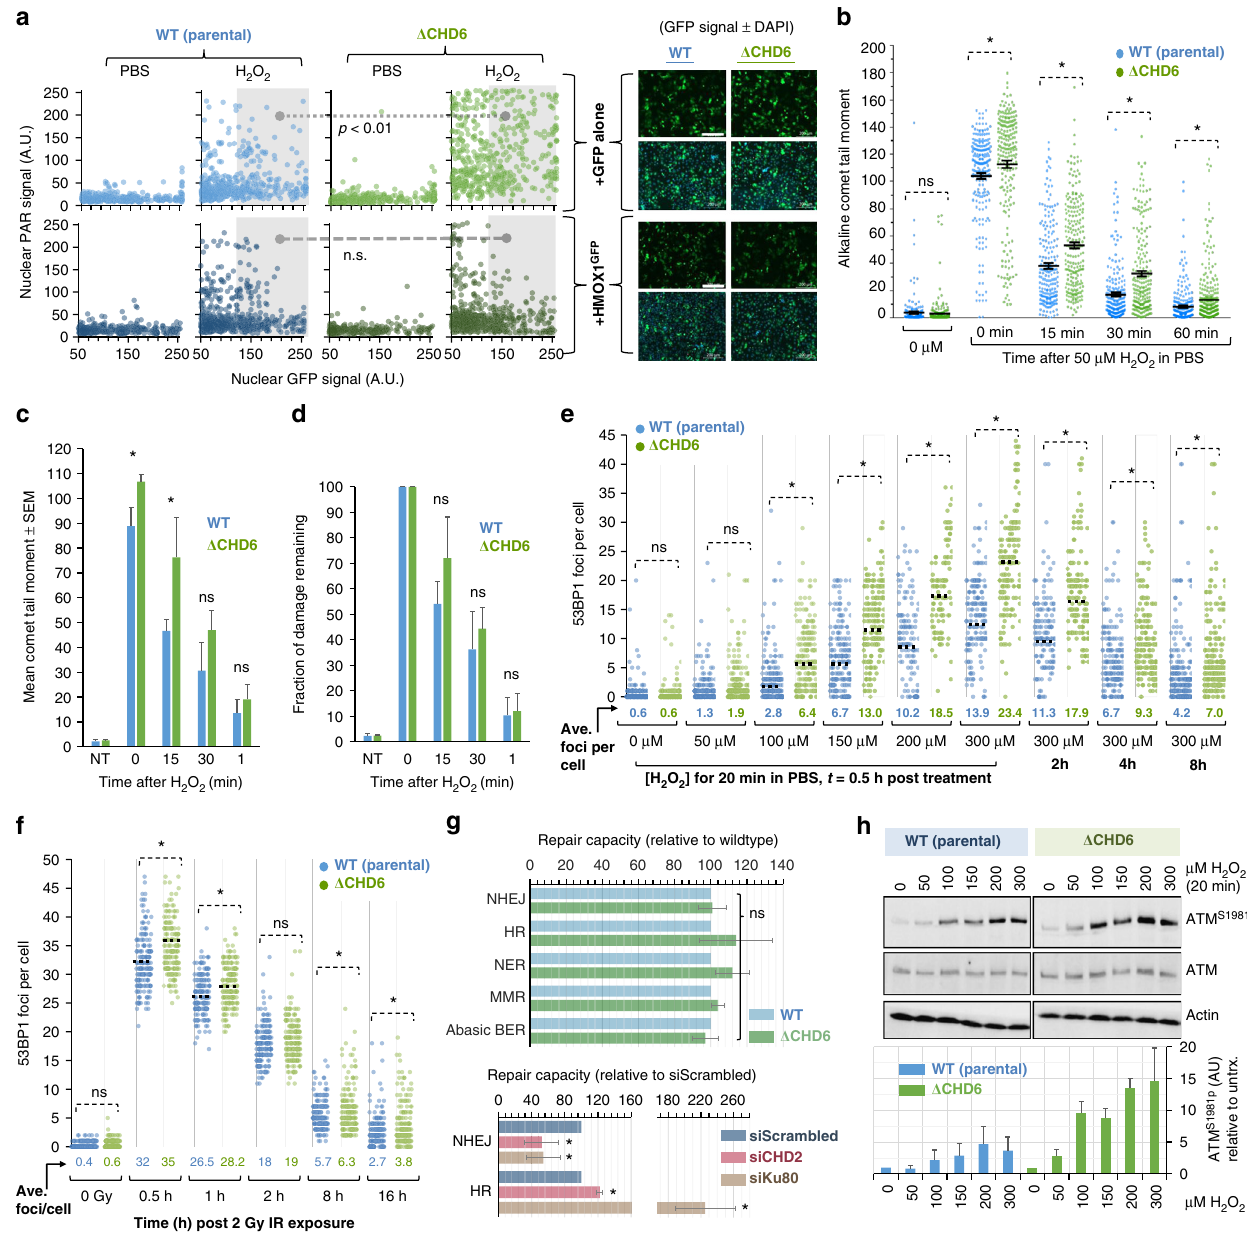
Fig. 5 CHD6-de fi cient cells display increased single-strand breakage, DNA damage signaling but normal DNA repair capacity. a WT and Δ CHD6 A549 were transfected with GFP or HMOX1 GFP and treated with 5 µ M PARGi ± 1 mM H 2 O 2 in media for 1 h before immunostaining for PAR. Nuclear PAR and GFP signal was quanti fi ed by ImageJ. Right panels = representative images indicating GFP (green) and/or DAPI (blue) signal in each condition. b – d WT and Δ CHD6 A549 in suspension were treated with 50 µ M H 2 O 2 and analyzed by alkaline comet assay as in Methods; b raw data from single experiment; c mean comet tail moment for n = 3; error bars = s.e.m.; d data normalized to induced damage (0 min time point). Error bars = s.e.m. e WT and A549 Δ CHD6 were exposed to 0 – 300 µ M H 2 O 2 in PBS for 20 min, washed, returned to media for 0.5 – 8 h, fi xed and immunostained for 53BP1. 53BP1 foci per cell were enumerated for >50 – 100 cells per n , n = 3. Graph indicates scatters of foci per cell across population; average number of foci per cell are indicated. f Cells from ( a ) were irradiated and harvested at indicated time points, then processed and analyzed as in ( a ). g (Top) WT, A549 Δ CHD6 were incubated for 4 h at 3% O 2 for acclimatization and transfected with FM-HCR reporter plasmids (see Methods). A549 Δ CHD6 repair capacity for each substrate was normalized to WT values, and is represented as relative repair capacity. (Bottom) A549 were transfected (48 h earlier) with scrambled, CHD2 or Ku80 siRNA, and transfected 48 h later with FM-HCR plasmids. Error bars = s.e.m.; n = 3. h WT and A549 Δ CHD6 were exposed to 0 – 300 µ M H 2 O 2 in PBS for 20 min, washed, returned to media for 0.5 h and immunoblotted for ATM S1981p , ATM and actin. Average signal from n = 3 is indicated in lower panel, error bars = s.d. In all cases, P values are for Student ’ s t -test: ns not signi fi cant ( P > 0.05); * P < 0.05. In all cases, ±refers to with and without, blue refers to WT cells; green refers to Δ CHD6